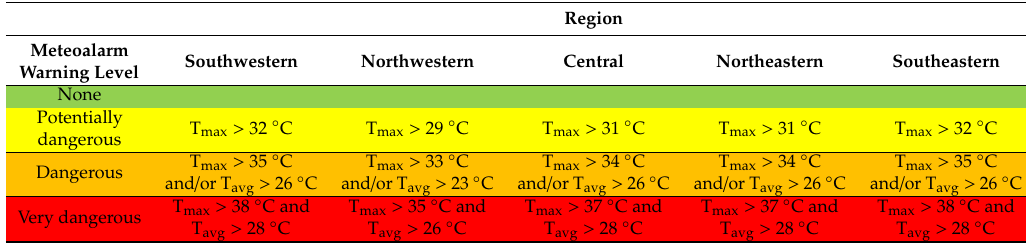
Table 1. Meteoalarm warning level criteria for heat in Slovenia (T max —maximum daily temperature, T avg —average daily temperature)